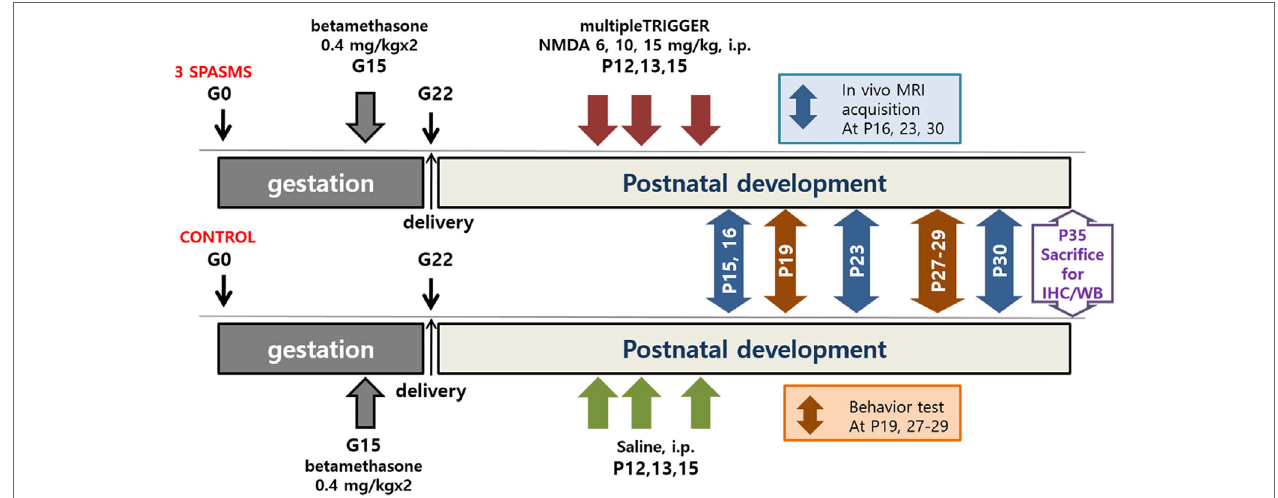
Figure 1 | Timeline of N -methyl- d -aspartate (NMDA)-induced spasms, MRI acquisition, behavioral tests, and tissue collection. IHC, immunohistochemistry; WB, western blot.